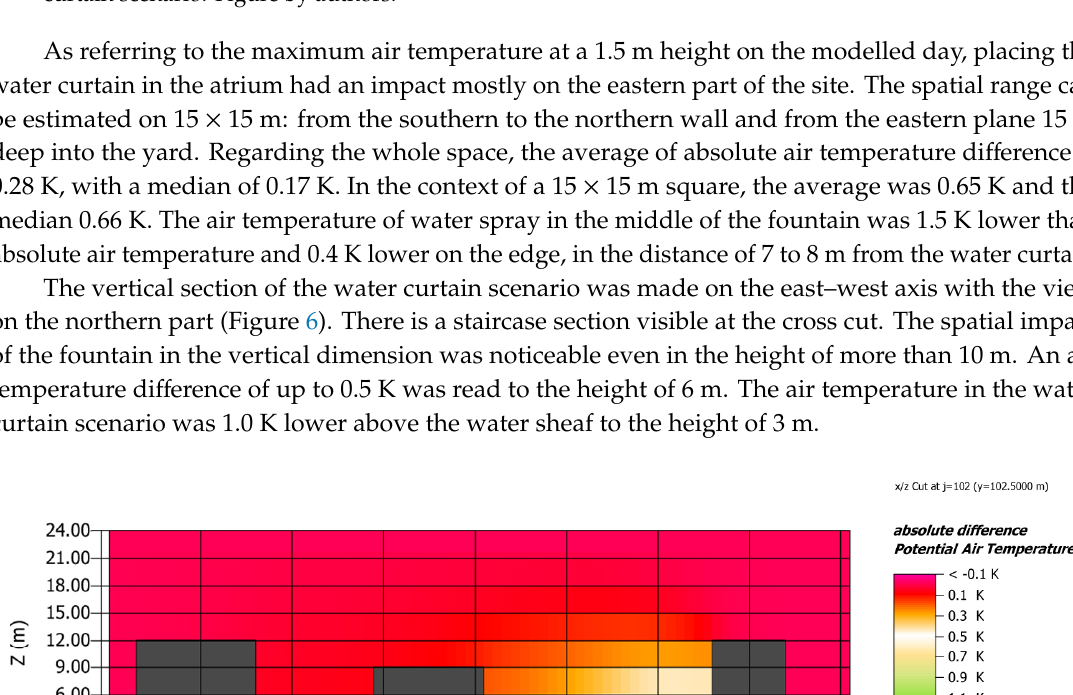
Figure 6. The difference of air temperature between the absolute current state and the reference water curtain scenario in the cross cut; view in north direction. Figure by authors.